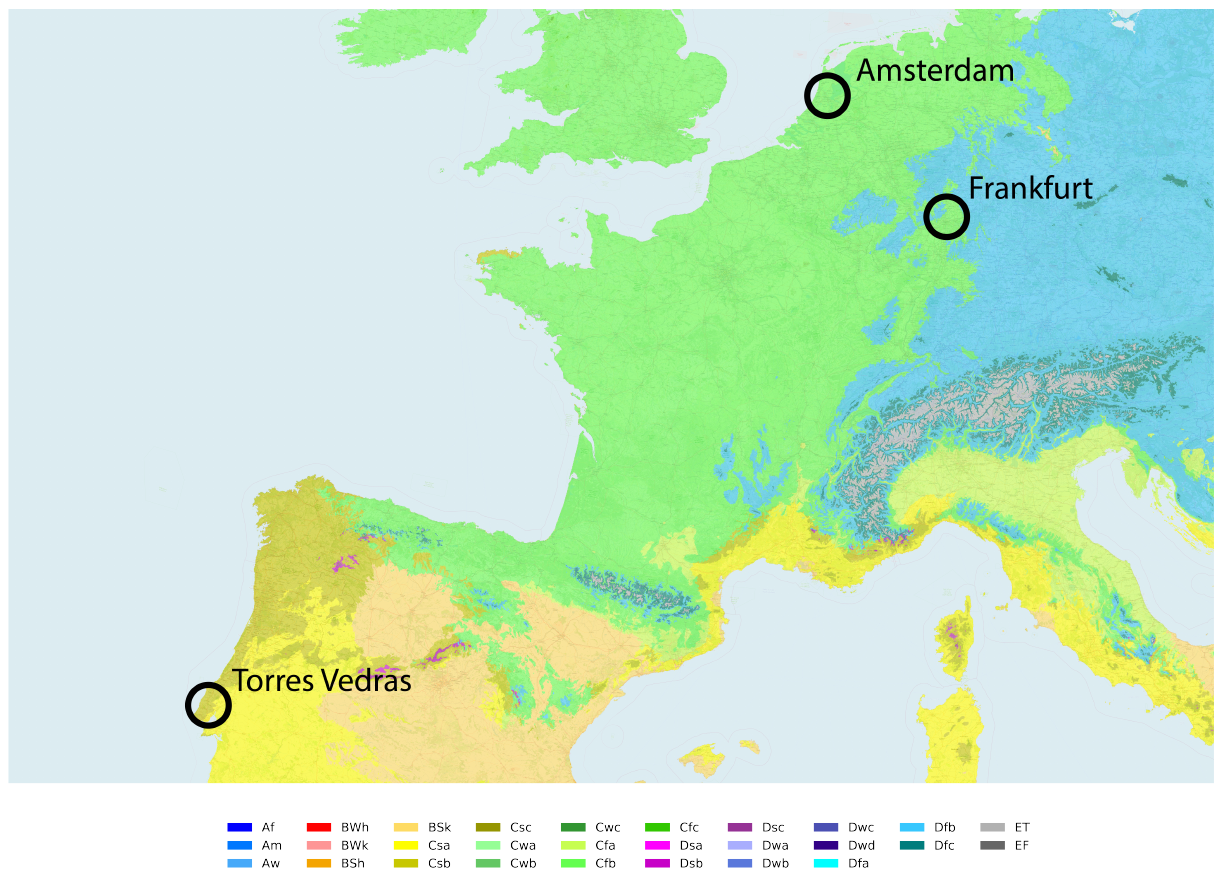
Figure 6. A map of Central Europe, with climate zones according to the Köppen–Geiger classification [32]. Amsterdam, Frankfurt and Torres Vedras are marked on the